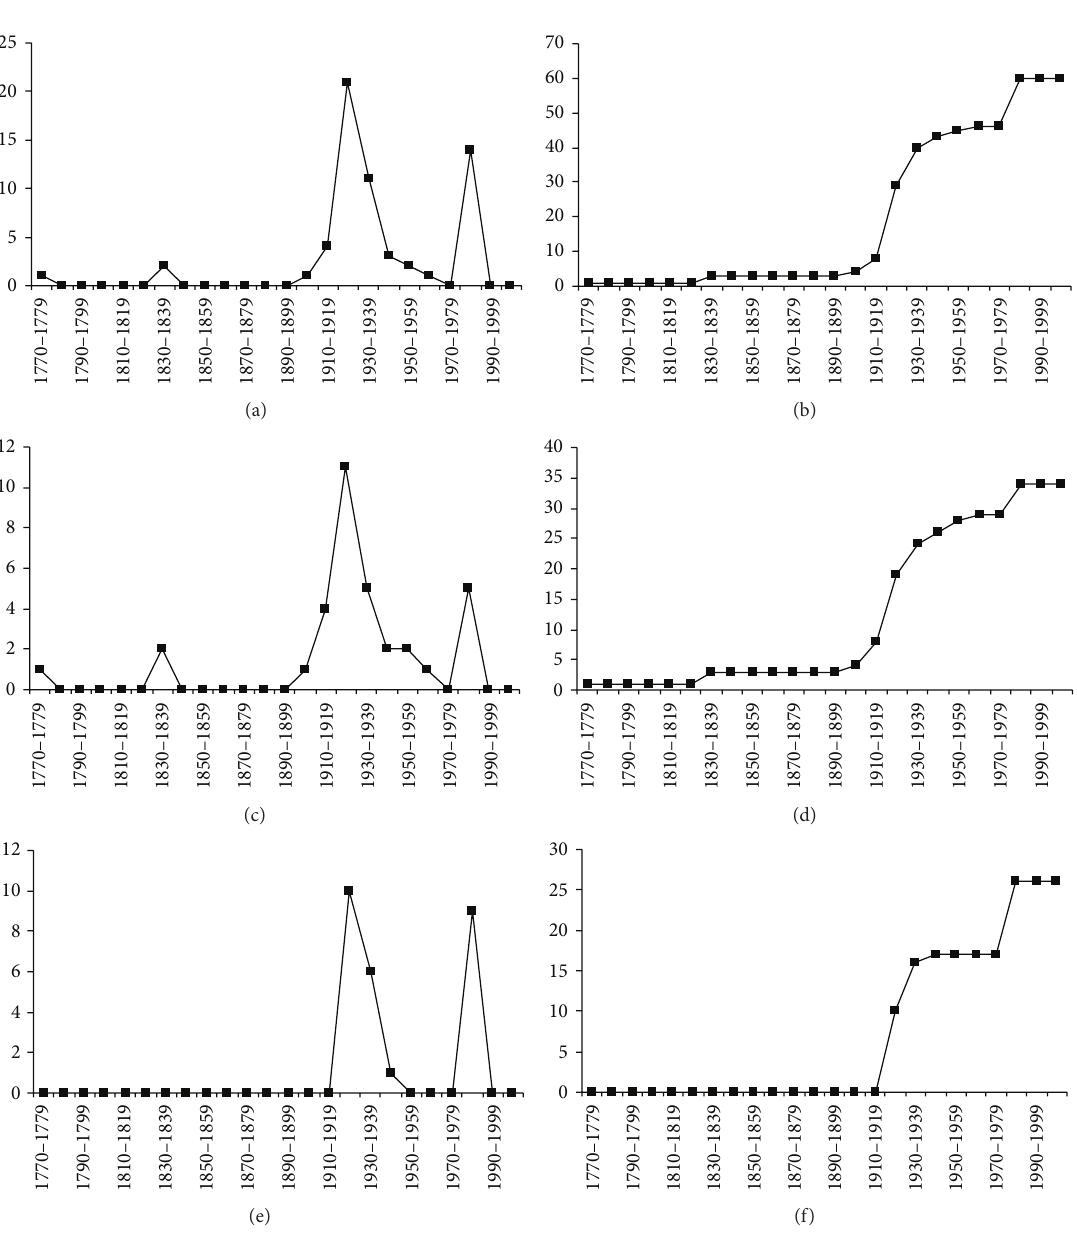
knowledge in Australia rested at the 1930s [22]. The lack of recent taxonomic activity, coupled with the low number of described species and the high percentage of synonyms, indicates that the fauna of this region is still poorly